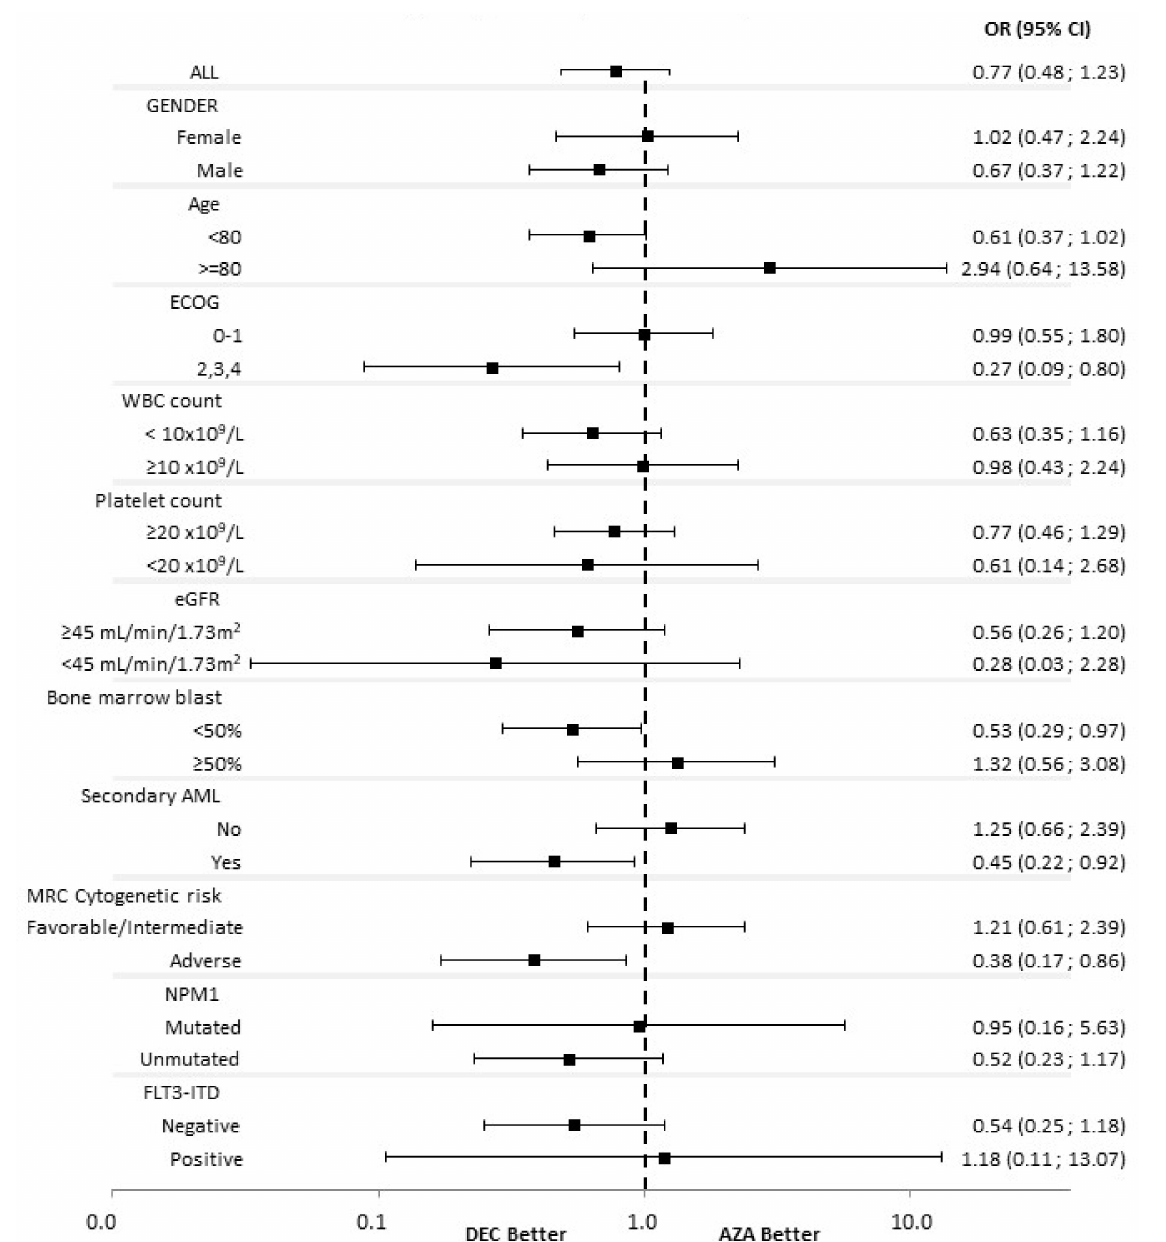
Figure 1. Subgroup analysis for CR/CRi. AML, Acute myeloid leukemia; AZA, azacitidine; CR,